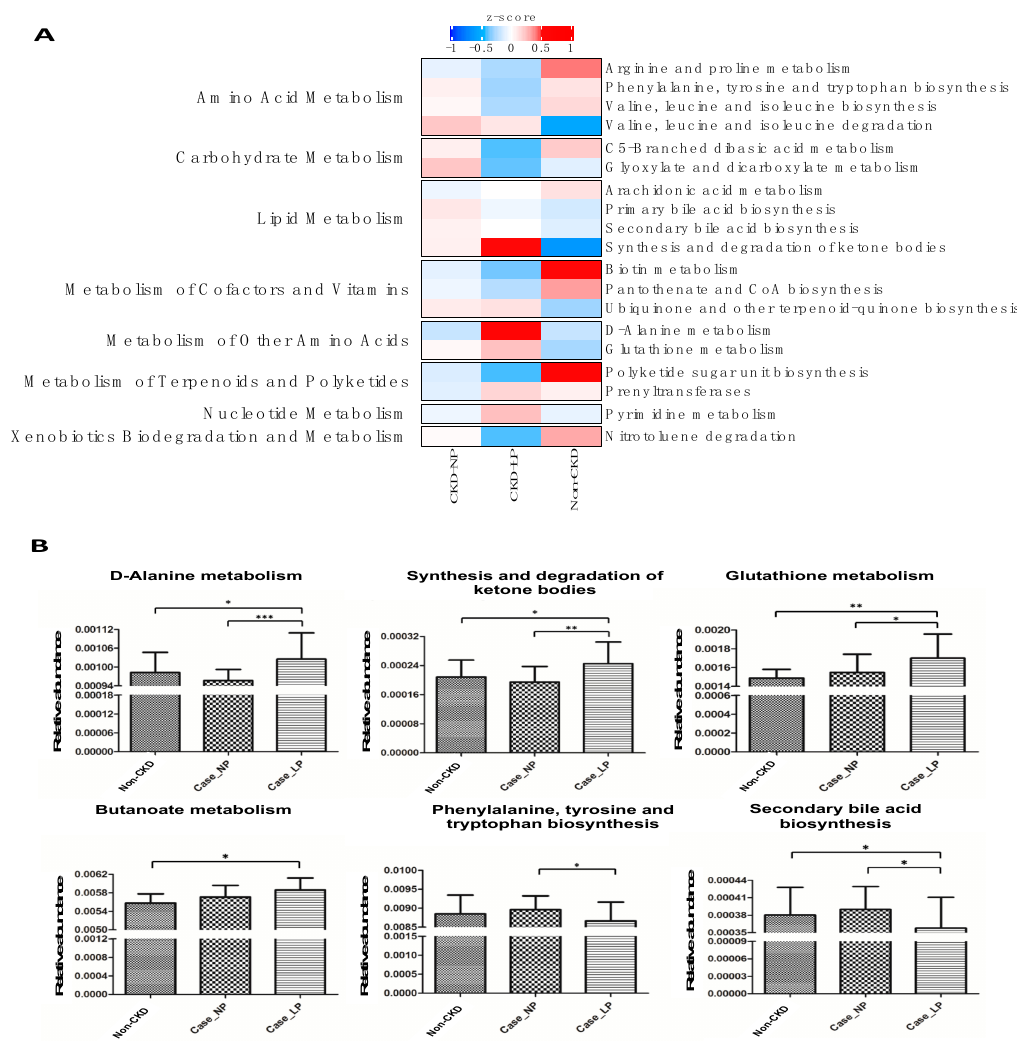
Figure 3. Prediction of microbial gene functions among groups. ( A ) Pathway enrichment for KEGG metabolism was inferred by PICRUSt. Differences in relative abundance of predicted microbial genes related to the metabolism among groups. ( B ) Changes of specific pathway modules associated with LP in CKD patients. Differences in relative abundances of predicted microbial genes among LP vs. NP were analyzed using Student’s t test. *, p < 0.05; **, p < 0.01; ***, p < 0.001. LP, low protein diet; NP, normal-protein diet; CKD, chronic kidney disease.